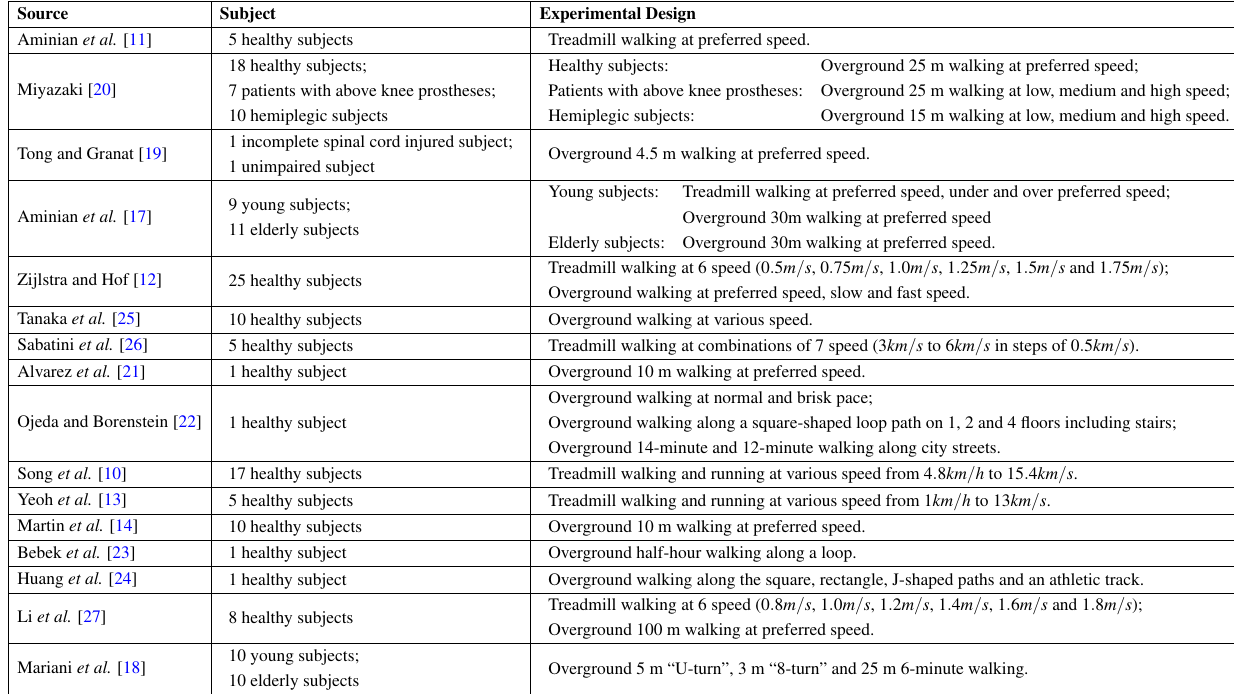
Table 3. Experimental Design in Reviewed